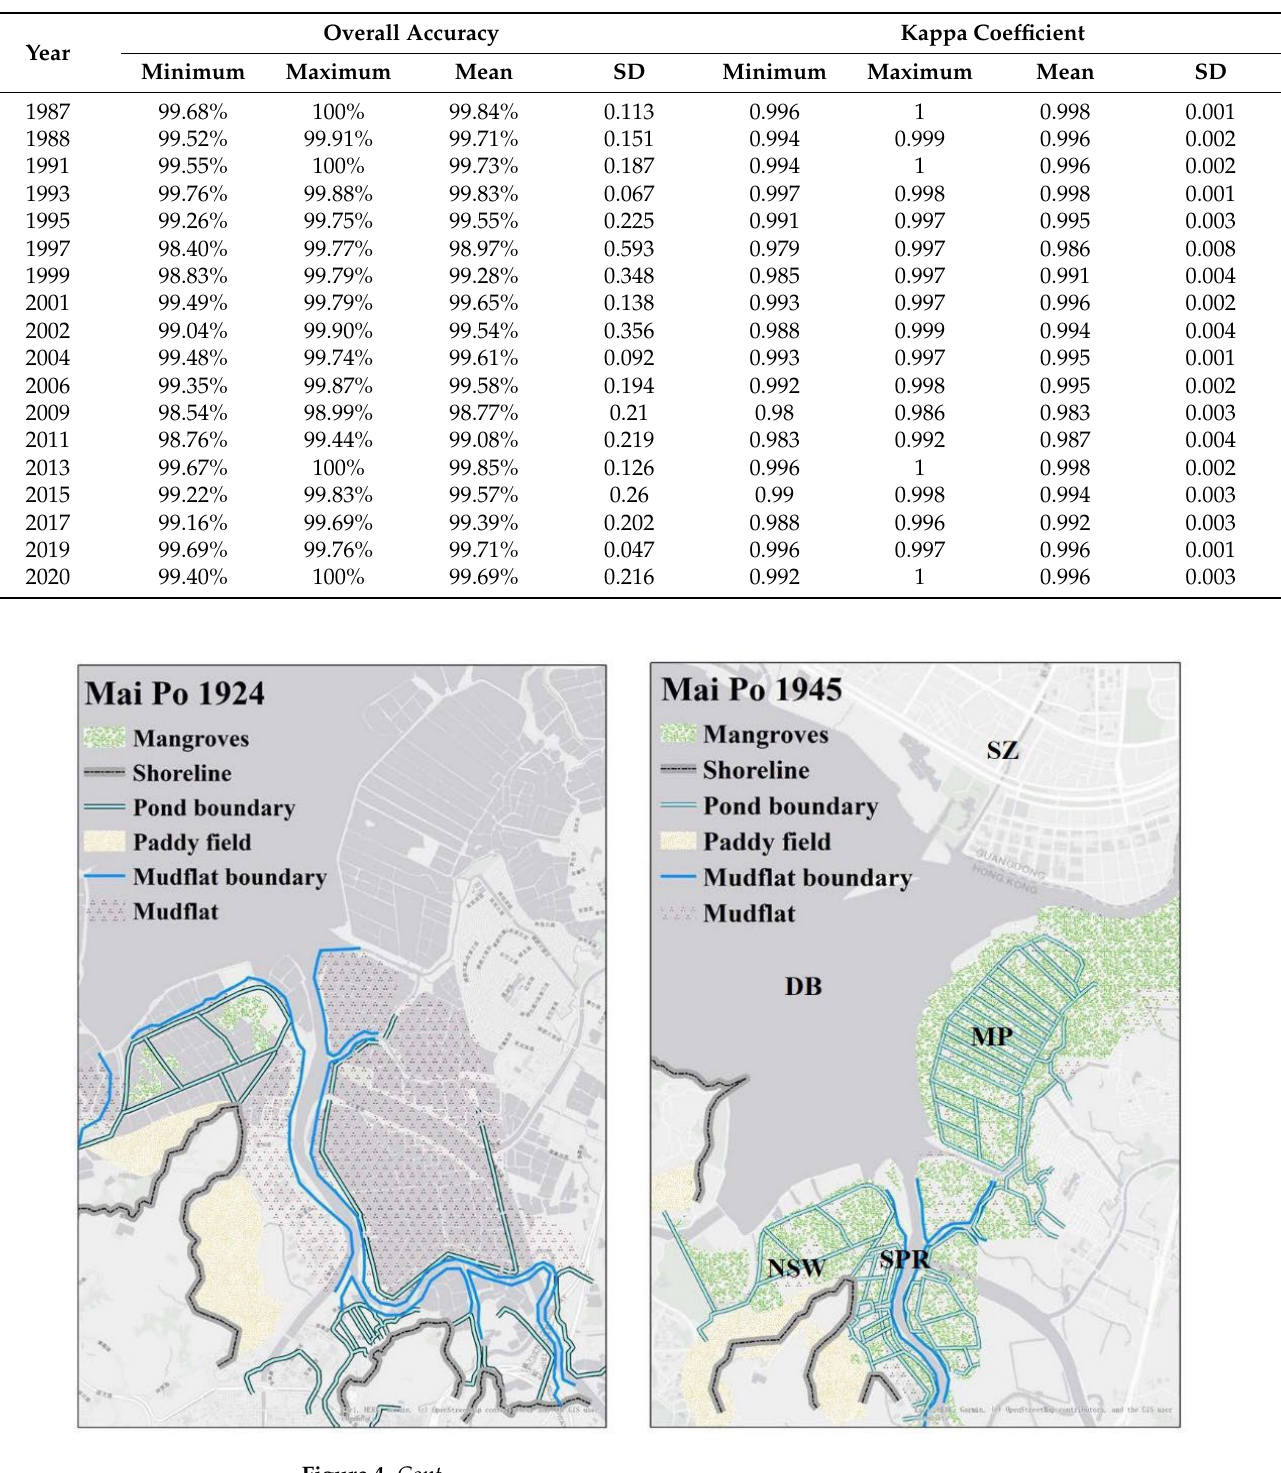
Figure 4. Mapping results are based on historical aerial photos from 1924 to 1964. The scales are: 1:14,332 (1924); 1:12,000 (1945); 1:25,029 (1954); and 1:25,029 (1964). Relevant locations are indicated: Deep Bay (DB), Mai Po (MP), Shan Pui River (SPR), Nam Sang Wai (NSW), and Shenzhen (SZ) in the top right panel for reference.